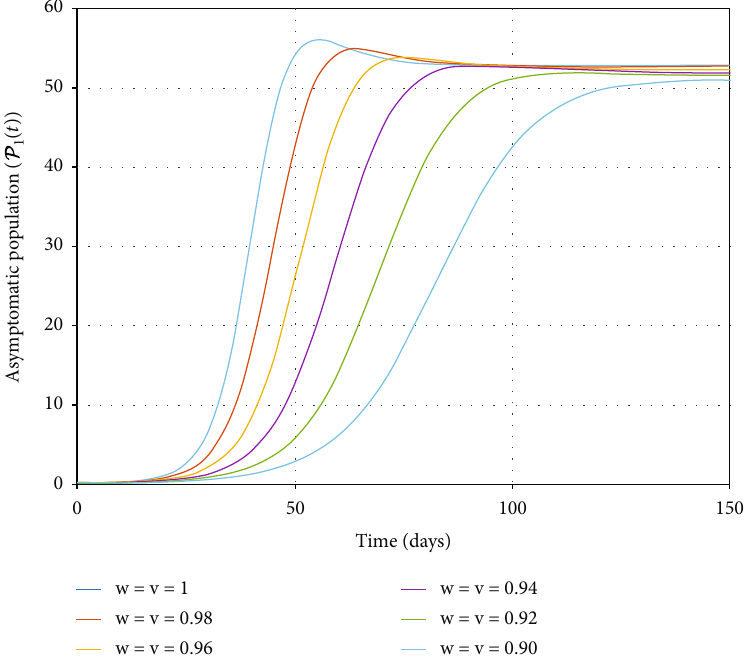
Figure 5: Behavior of P